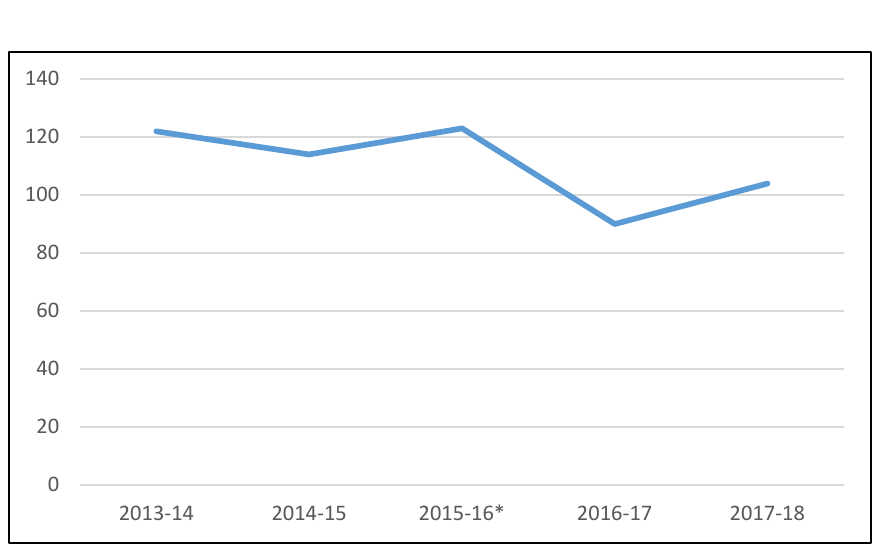
Number of Library Classes Taught by Academic Year *Last Year Library Instruction Required for all FYS